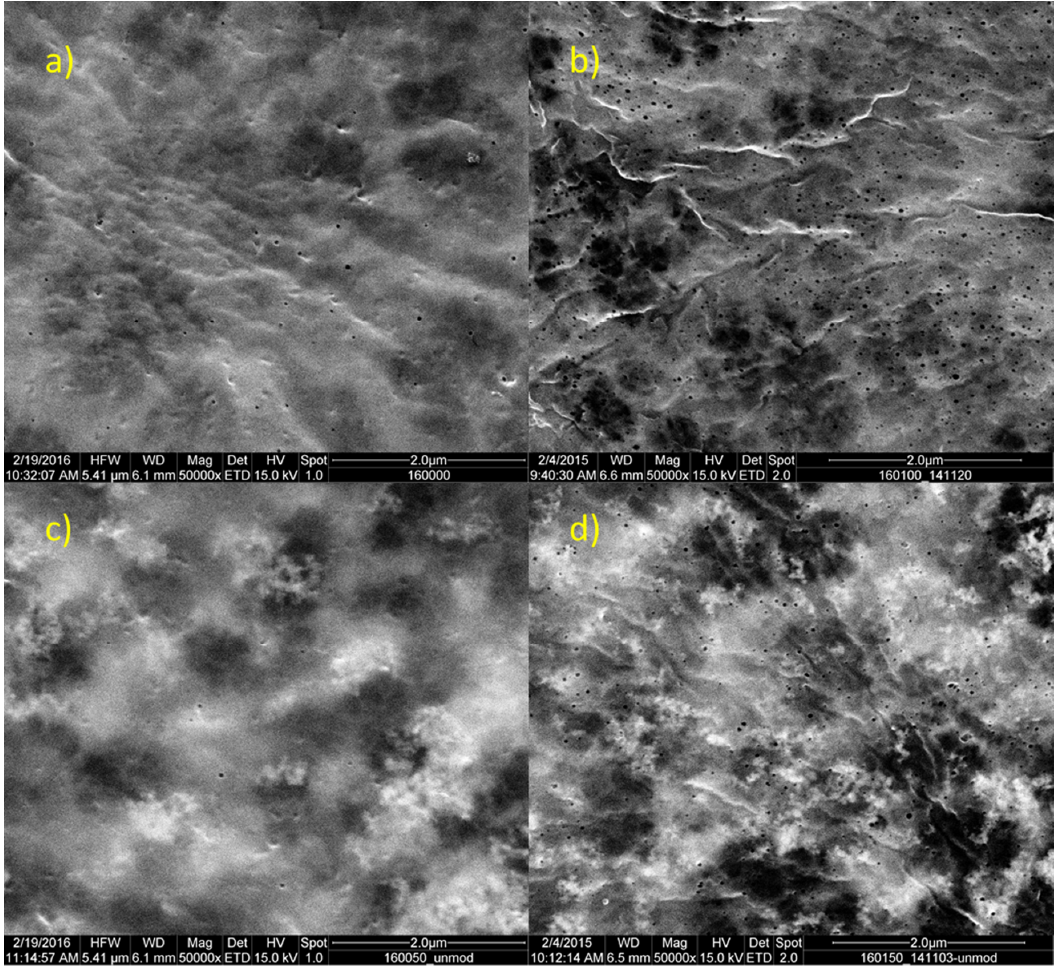
Figure 2. Outer surface morphology of PVDF membranes with and without PVP as well as without and with ZnO nanoparticles. ( a ) 0% PVP, 0% NP; ( b ) 1% PVP, 0% NP; ( c ) 0% PVP, 50% NP; ( d ) 1% PVP, 50% NP; magnification 50,000×. Membranes 2020 , 10 , x FOR PEER REVIEW